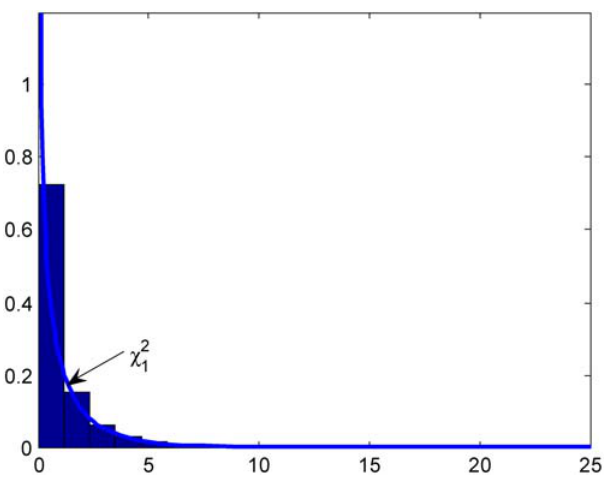
Figure 2. Null Distribution of the statistic T G and controls